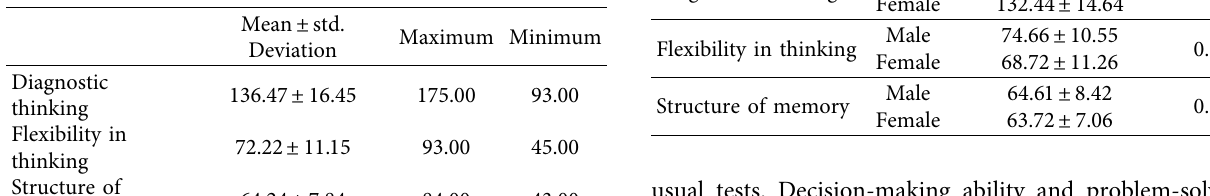
Table 3: Diagnostic thinking scores of students in different domains.